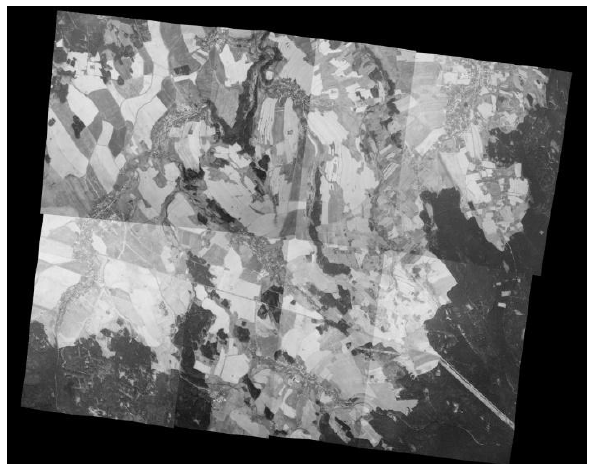
Figure 13 Orthophoto from the testing locality, recorded in 1962